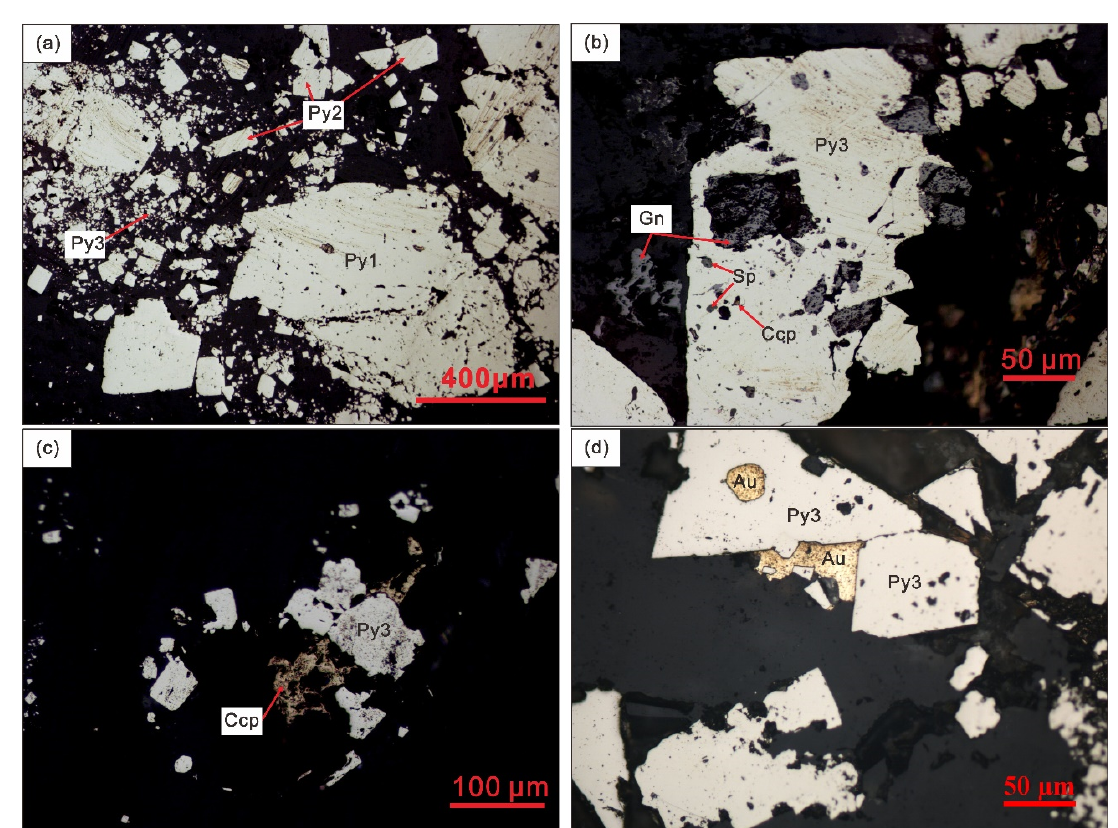
Figure 6. Representative photomicrographs showing the major metallic minerals of the Longquanzhan gold deposit. ( a ) Coarse to fine-grained, subhedral to anhedral pyrite (Py1, Py2, and Py3); ( b ) medium to fine-grained, subhedral pyrite (Py3) intergrown with chalcopyrite, galena, and sphalerite; ( c ) pyrite (Py3) intergrown with chalcopyrite in gold-quartz- polymetallic sulfide stage; ( d ) gold inclusions in the third pyrite stage and fillings between pyrite and quartz. Abbreviations: Py = pyrite; Ccp = chalcopyrite; Gn = galena; Sp = sphalerite; Au =gold. Minerals 2020 , 10 , x FOR PEER REVIEW